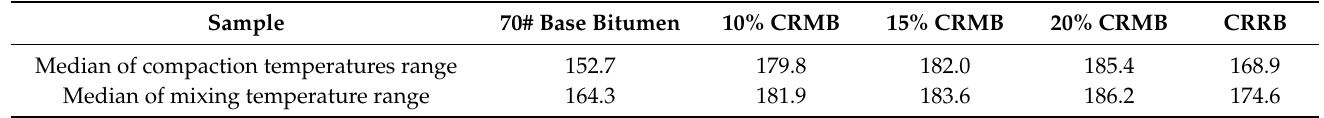
Table 5. Median of compaction temperature range and mixing temperature range of